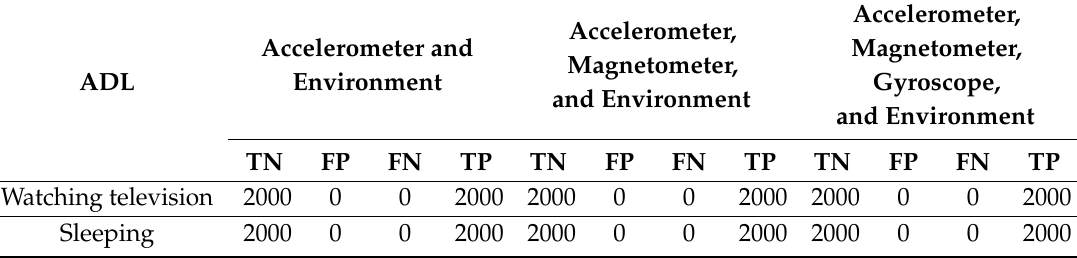
Table 15. Confusion matrix values of the recognition of activities without motion using the AdaBoost with the decision stump method implemented with Weka software for motion and magnetic sensors after the recognition of the environment (TP = True Positive; TN = True Negative; FP = False Positive; FN = False